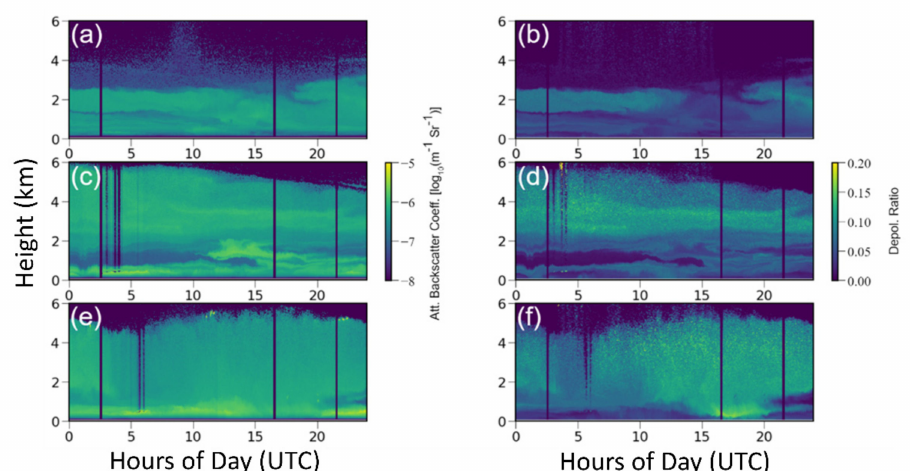
Figure 10. Lidar attenuated backscatter coefficient (left column) and particle linear depolarization ratio (right column) of the reference case on 10 September 2017 ( a , b ), for the case of the Middle East on 15 of September 2017 ( c , d ), and for the case of Saharan dust particles on 21 September 2017 ( e , f ).